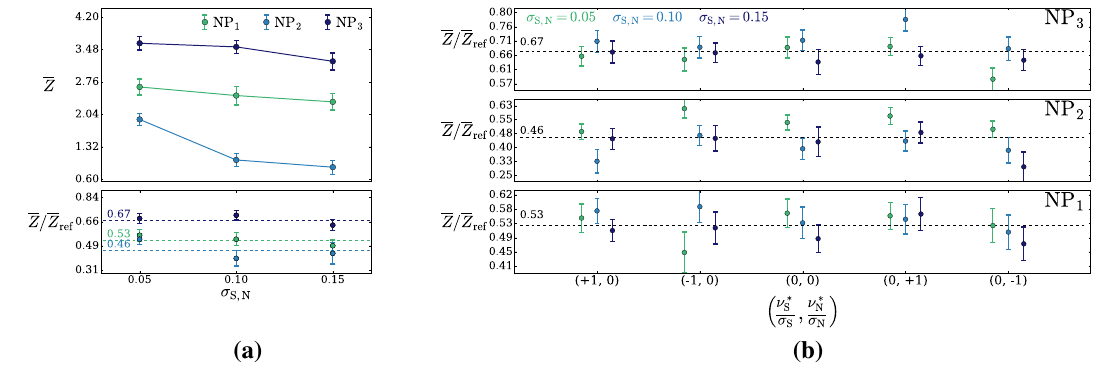
Fig. 8 The median Z -score ( Z ) obtained with our model-independent strategy, compared to the median reference Z -score ( Z ref ) of a model- dependent search (see the main text) optimized for each of the three new physics scenarios in Eqs. (32)–(34). The left panel a shows the dependence of Z on the nuisance parameter uncertainties, and the mild dependence of the ratio Z / Z ref . The left panel is obtained with NP